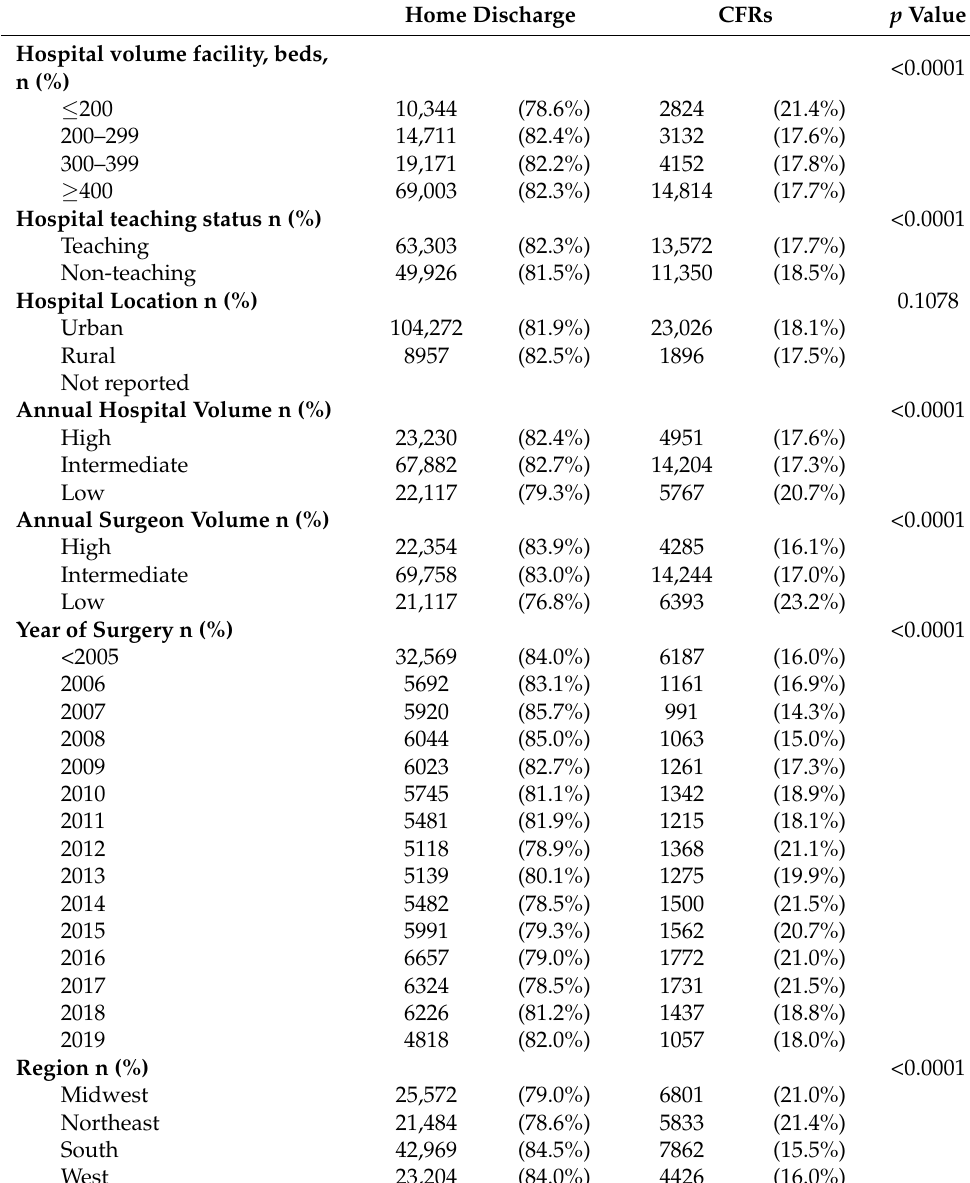
Table 2. Facility